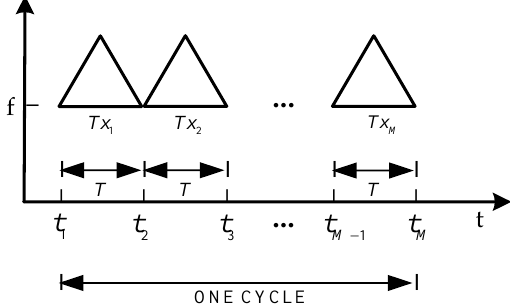
Figure 6. The transmission scheme of the system.